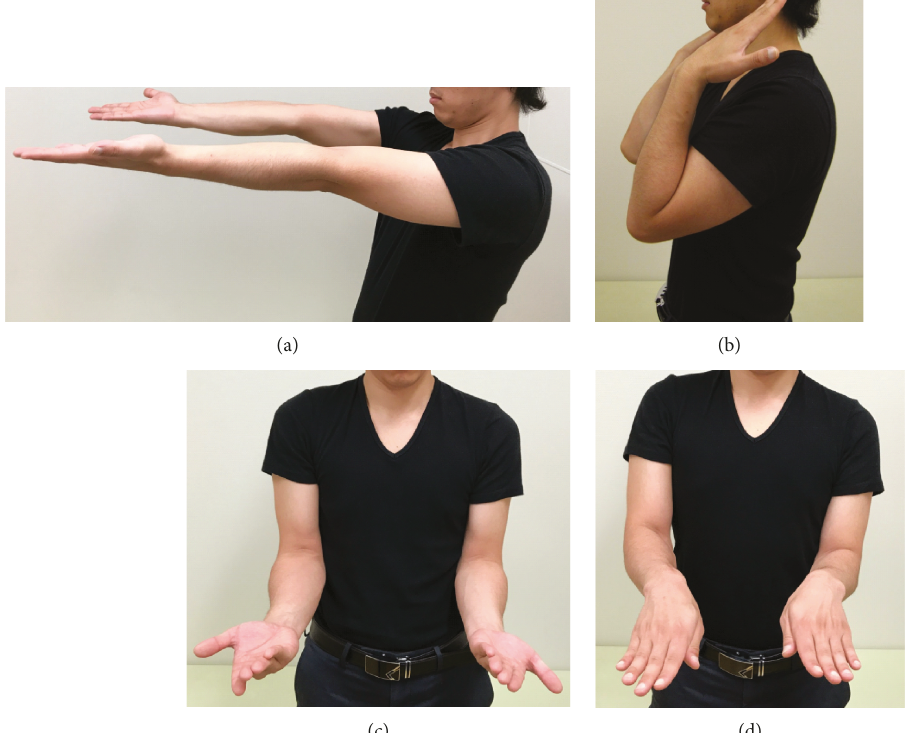
Figure 5: Twenty-one years after surgery. (a) Extended elbow. (b) Flexed elbow. (c) Forearm supination. (d) Forearm